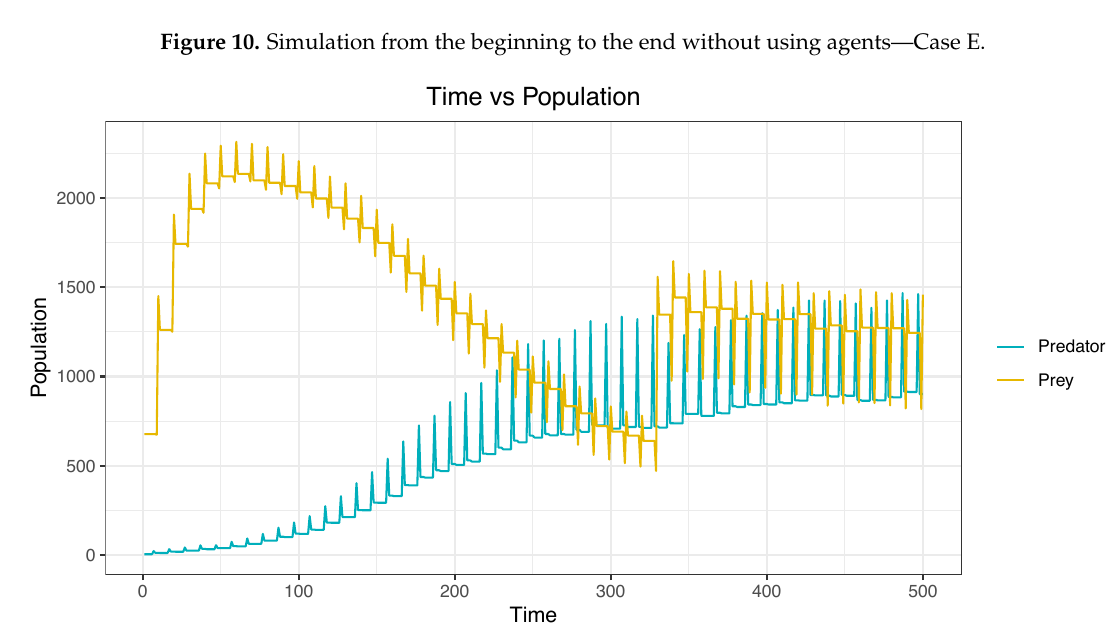
Figure 11. Simulation from beginning to end using agents—Case